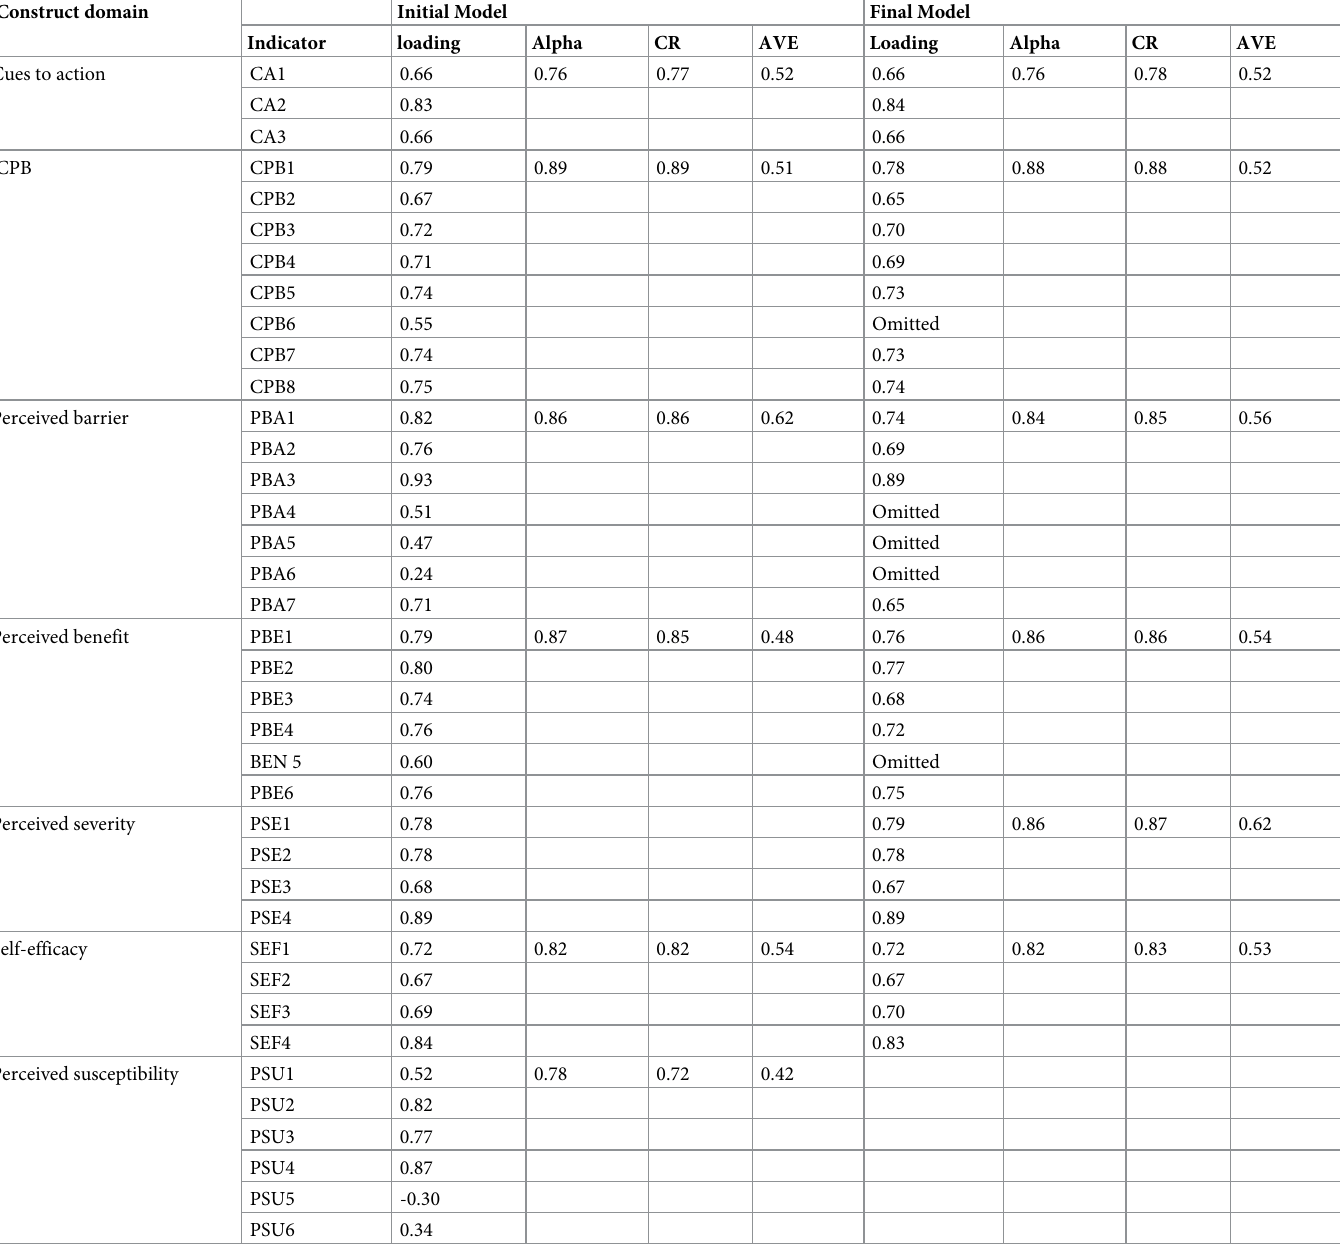
Table 5. The reliability and convergent validity tests results of the instrument used to assess students CPB based on the Health Belief Model in Gondar city, North- west Ethiopia, 2020 (n = 370). Construct